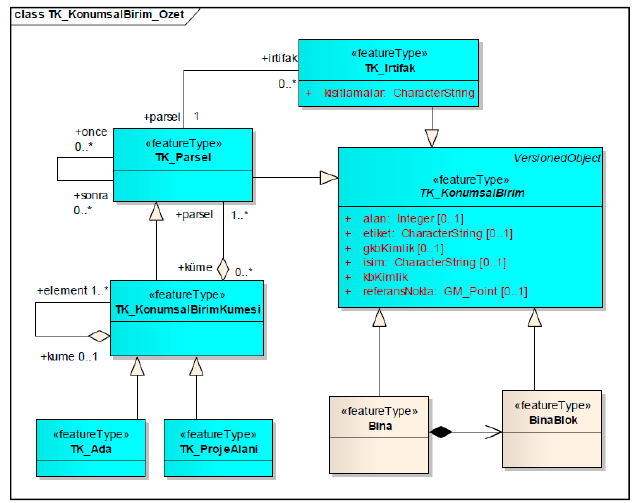
Figure 5. Spatial unit class types. Translation of some of the expressions: ‘Parsel’ = ‘Parcel’, ‘Bina’ = ‘Building’, ‘BinaBlok’ = ‘BuildingBlock’, ‘KonumsalBirimKümesi’ = ‘SpatialUnitCollection’, ‘Ada’ = ‘ParcelBlock’, ‘ProjeAlan ı ’ = ‘ProjectArea ’, ‘ İ rtifak’ = ‘Easement’ [35].